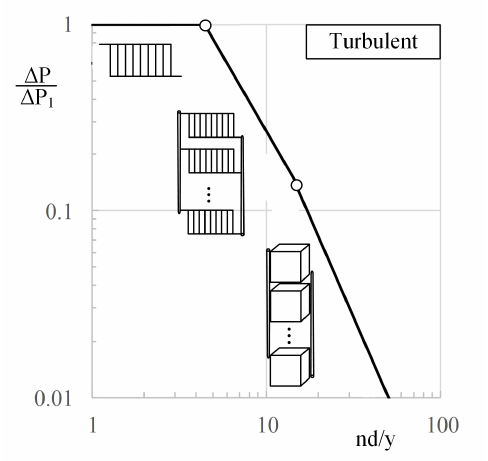
Figure 2: The pressure drop of three competing designs divided by the pressure drop of the design of stack of n elemental flow vol- umes for turbulent flow